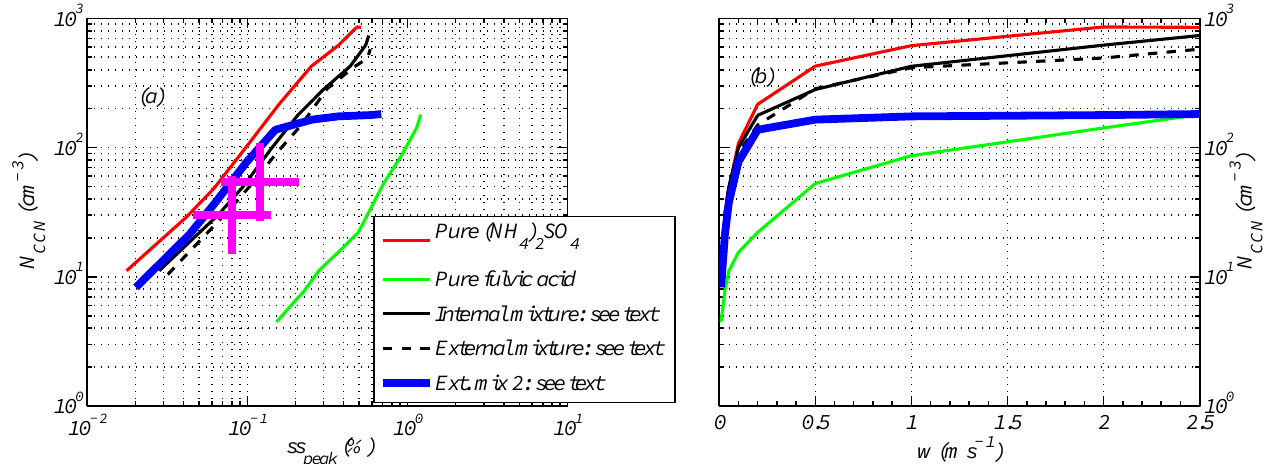
Fig. 7. (a) The results of parcel model simulations predicting the CCN concentration for different prescribed up-draught speeds plotted against the peak super-saturation attained, for different assumptions regarding mixed aerosol composition (see text). Also shown on the same plot are the measured CCN concentrations at super-saturations of 0.08 and 0.12% in the air below cloud base (from aircraft run R2 below cloud base); (b) the modelled CCN concentrations plotted against updraft speed for the same cases. The Pure (NH4) 2 SO 4 , Pure fulvic acid and Internal mixture cases correspond to runs that assume a constant composition across the whole size distribution (see Fig. 6a for a schematic); the External mixture case corresponds to an external mixture of three pure components, that have equal number ratios across the whole distribution (see text); and the Ext. mix 2 case refers to an assumption where the smallest mode has a composition that is a non- hygroscopic organic acid with the other modes set to an internal mixture as described in the text (see Fig. 6b for a schematic). The effect that this latter assumption has is to limit the maximum number activated to approximately 180cm − 3 for updrafts larger than ∼ 0 . 5ms − 1